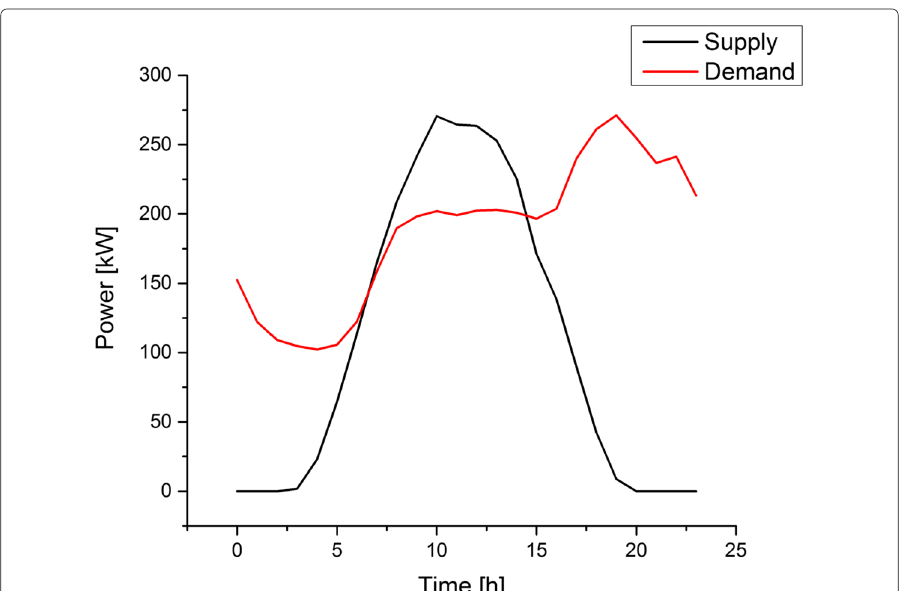
Fig. 2 Aggregate load and production profiles - rooftop solar production only